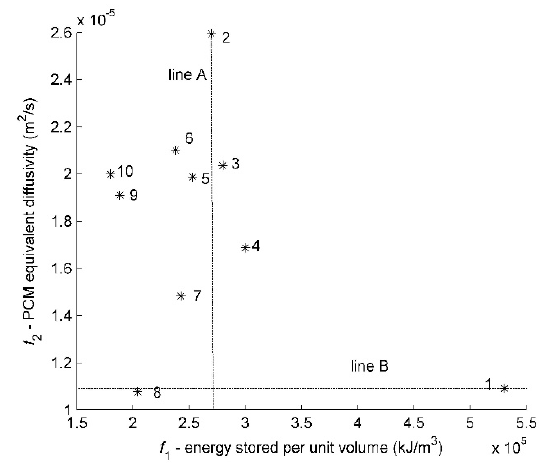
Figure 3. Illustration of an objective map used for the MODM examination [27] in which the f 1 values of ten PCMs (marked as No. 1 to 10 in the map) are plotted against their f 2 values. In this case, the preferred material alternatives are PCMs No. 1, 2, 3, and 4. If some of them are also ranked highly by the MADM, they will be recommended as the final decision of the material assessment step.